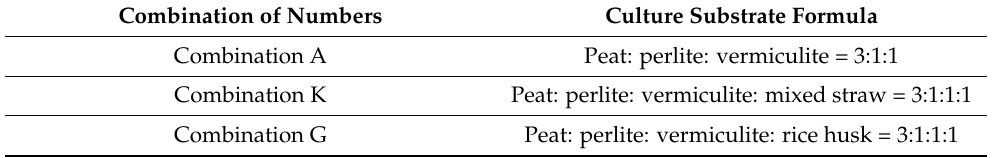
Table 1. Matrix formula. Combination of Numbers Culture Substrate Formula Combination